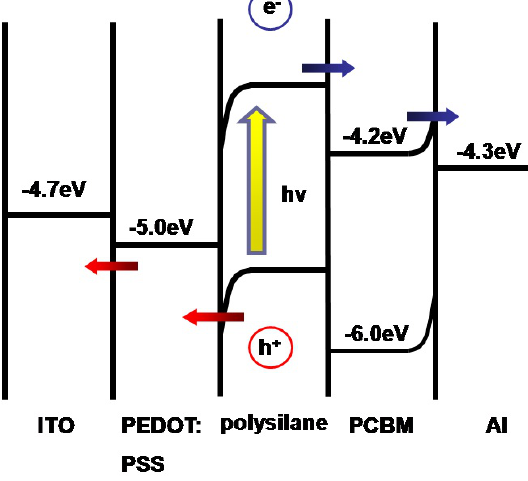
ported values were used for the energy levels [11–13]. The incident direction of light is from ITO side. Energy barrier